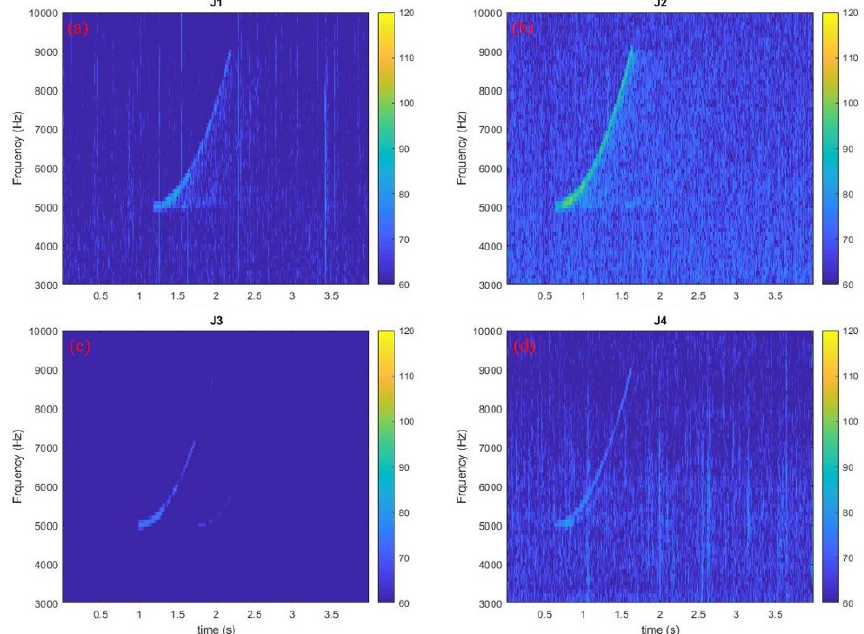
Figure 9. Received signal of each station when the source was at point T10. ( a ) J1 station; ( b ) J2 station; ( c ) J3 station; ( d ) J4 station.